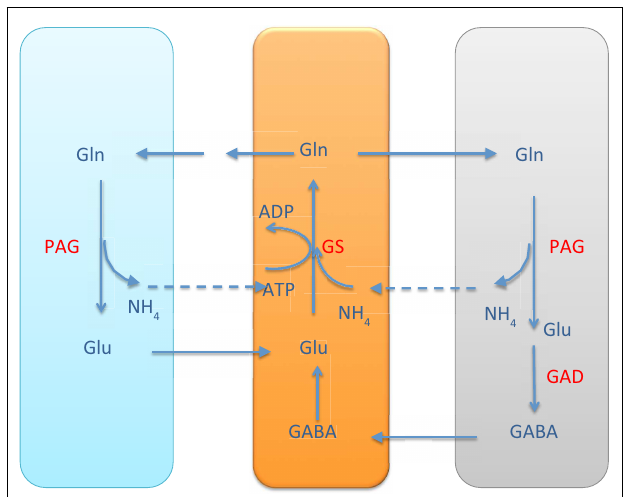
FIGURE 1 |The glutamate-glutamine cycle and GABA-glutamine cycles .The excess ammonium freed by PAG in the neurons needs to be transported back to astrocyte, where a shortage is created by the GS activity. In the pure glutamate/GABA-glutamine cycle paradigm, the ammonium diffusion or surrogate shuttle mechanisms need to go at the flux rate of the glutamine efflux from astrocyte.The quantitative analysis indicates that the full picture may be more complex.